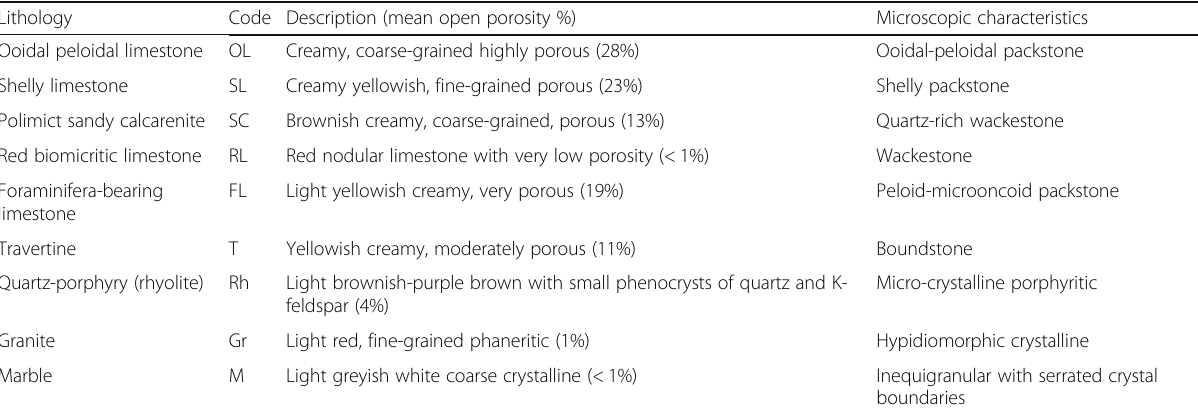
Table 1 Identified lithotypes and their major characteristics